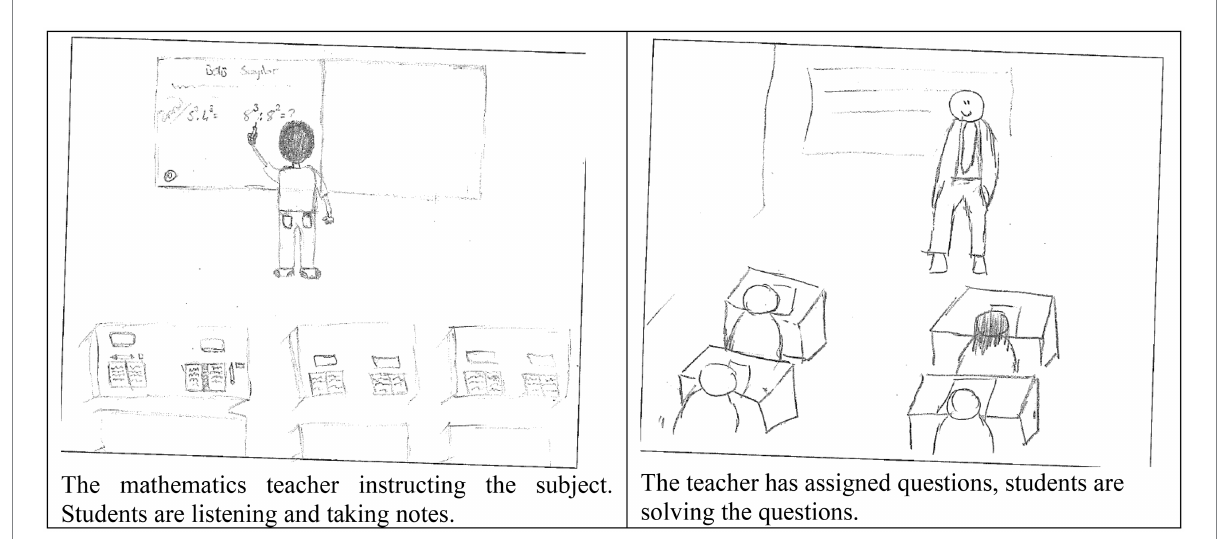
FIGURE 2 Examples of draw-a-mathematics-classroom-test (DAMC) research drawings (Hatisaru,